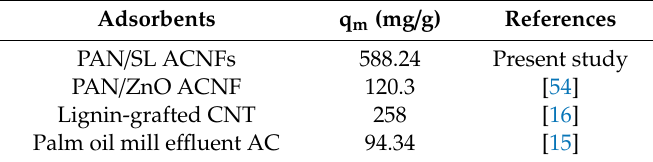
Table 5. Comparison of maximum adsorption capacity of PAN / SL ACNF with other literature